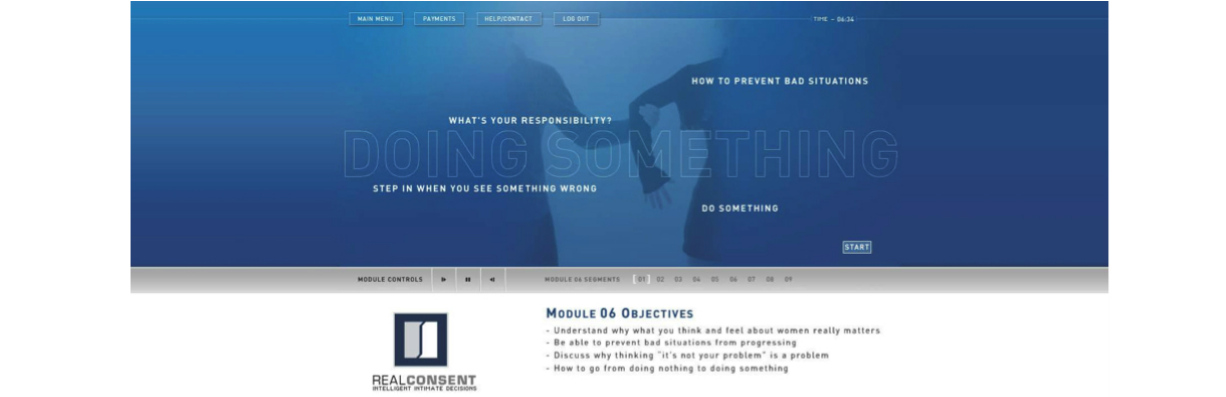
Figure 1. Screenshot of RealConsent’s bystander intervention